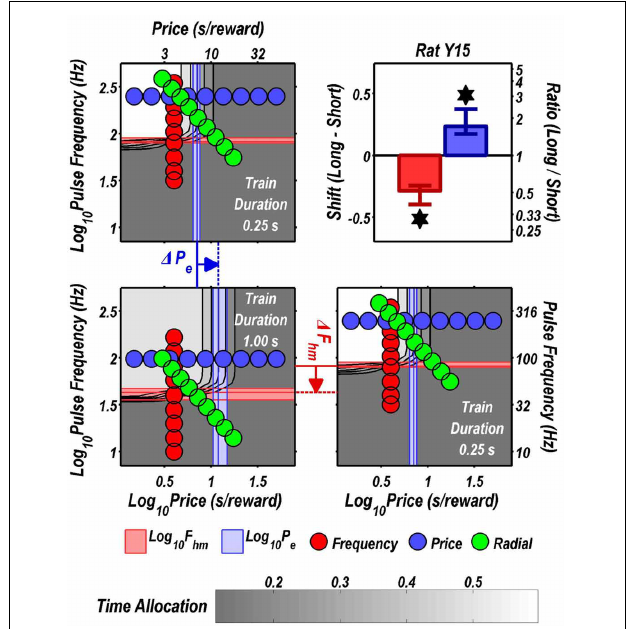
FIGURE 8 | Shifts of the reward mountain. The contour graph for the long-duration (1s) train is shown in the lower left. For comparison the contour graph for the short-duration (0.25s) train is shown twice, in the upper left and lower right. The P e parameter determines the location along the price axis, whereas the F hm parameter determines the location of the mountain along the pulse-frequency axis. The vertical blue line represents the estimate of P e , and the surrounding band represents the corresponding 95% confidence interval. The horizontal red line represents the estimate of F hm , and the surrounding band represents the corresponding 95% confidence interval. The bar graph shows the mean shifts in the location parameters due to the increase in train duration from 0.25 to 1s along with the associated 95% confidence intervals. ∗ Indicates that the 95% confidence interval does not include zero.